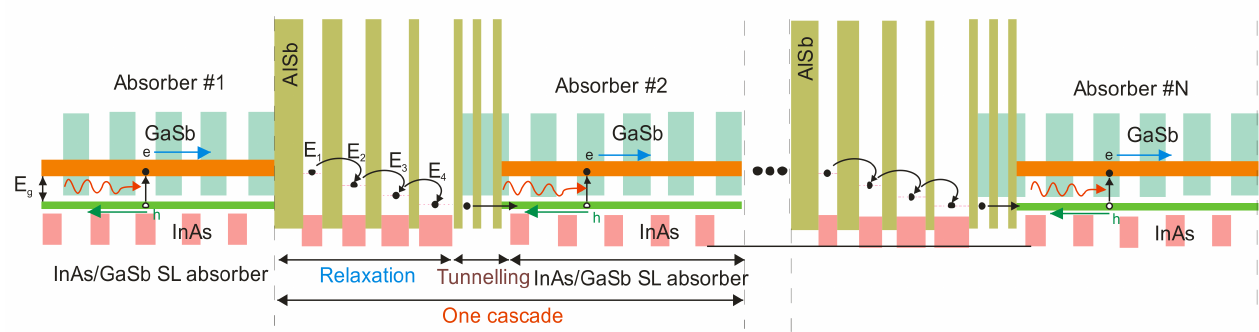
Figure 9. IB QCIP based on T2SL InAs/GaSb active, GaSb/AlSb tunneling and InAs/AlSb relaxation layers (after refer- ence